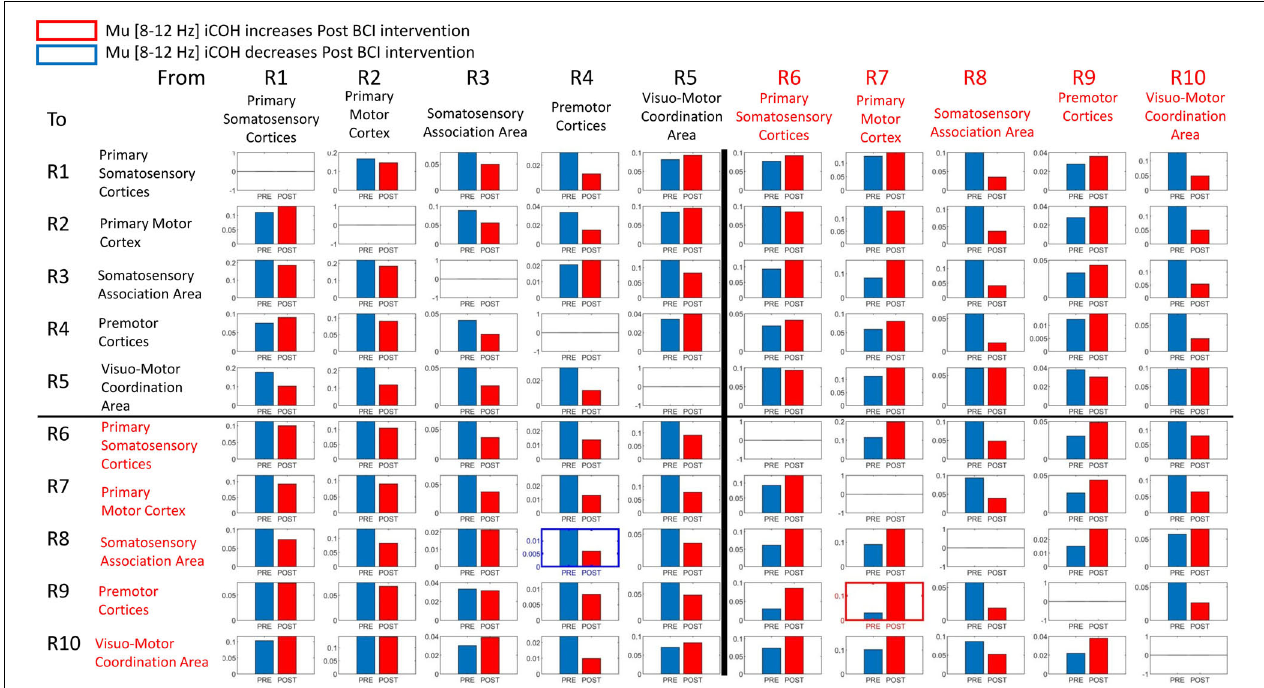
FIGURE 8 | Plots of iCoh between two given ROIs in the Mu frequency band [8–12 Hz], Pre and Post BCI intervention. Vertical axis: Coherence value –1 to 1. Horizontal axis: Pre (blue) and Post (red). Columns are senders, rows are receivers (i.e., FROM the top row of ROIs TO the horizontal columns of ROIs). Blue surrounding boxes indicate significant decrease in iCoh while red surrounding boxes denote significant increases in iCoh (Post vs. Pre).